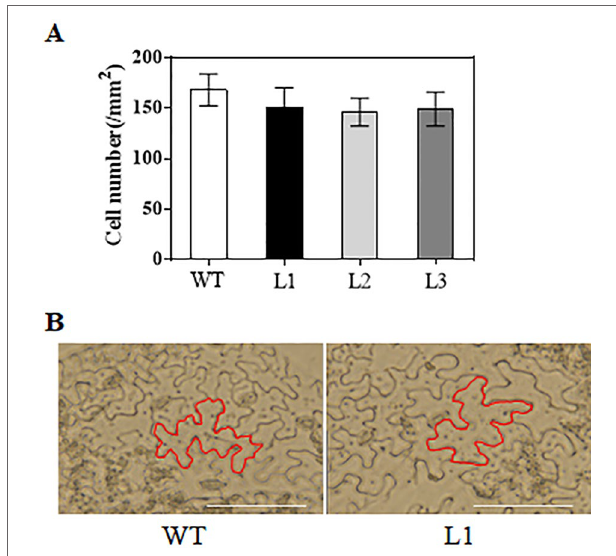
FIGURE 8 | Analysis of cell number (A) and cell size (B) in TaAP2-10-5D transgenic plants. Mean values were calculated from five biological replicates. Bars = 50 μm. Error bars represent standard